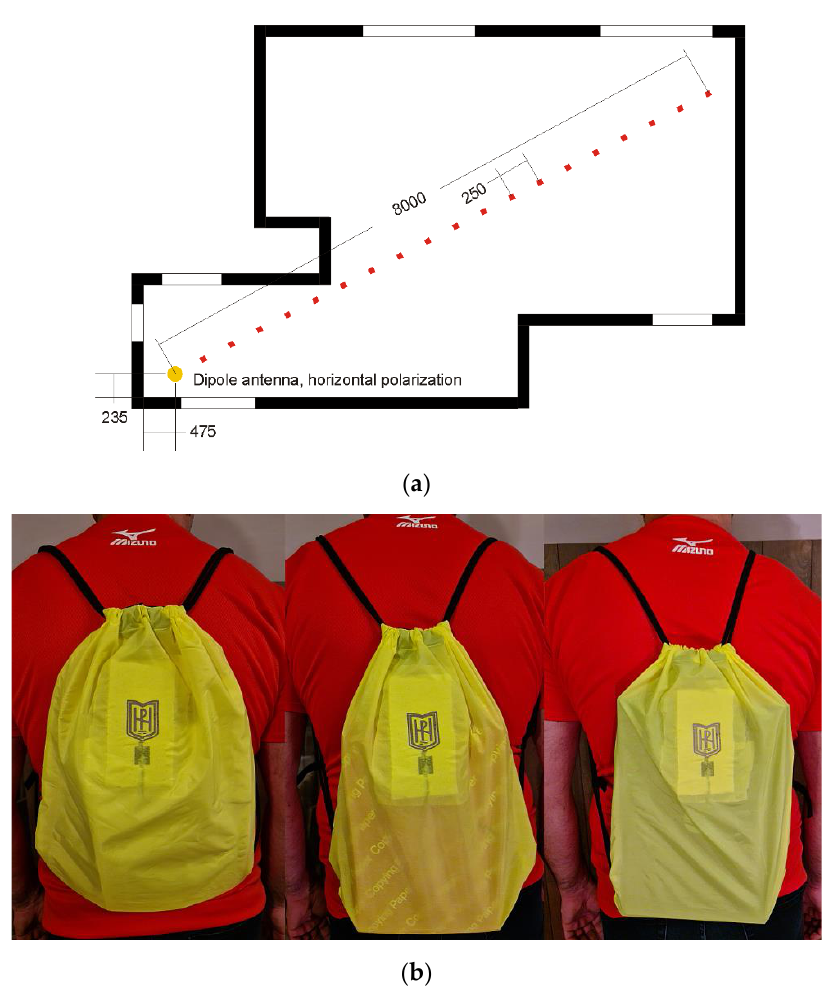
Figure 12. Measurement setup: ( a ) floor plan of the measurement locations and ( b ) photographs of the empty backpack, backpack with a package of copy-printer paper, and backpack with a laptop. The dimensions indicated in the figure are in millimeters.